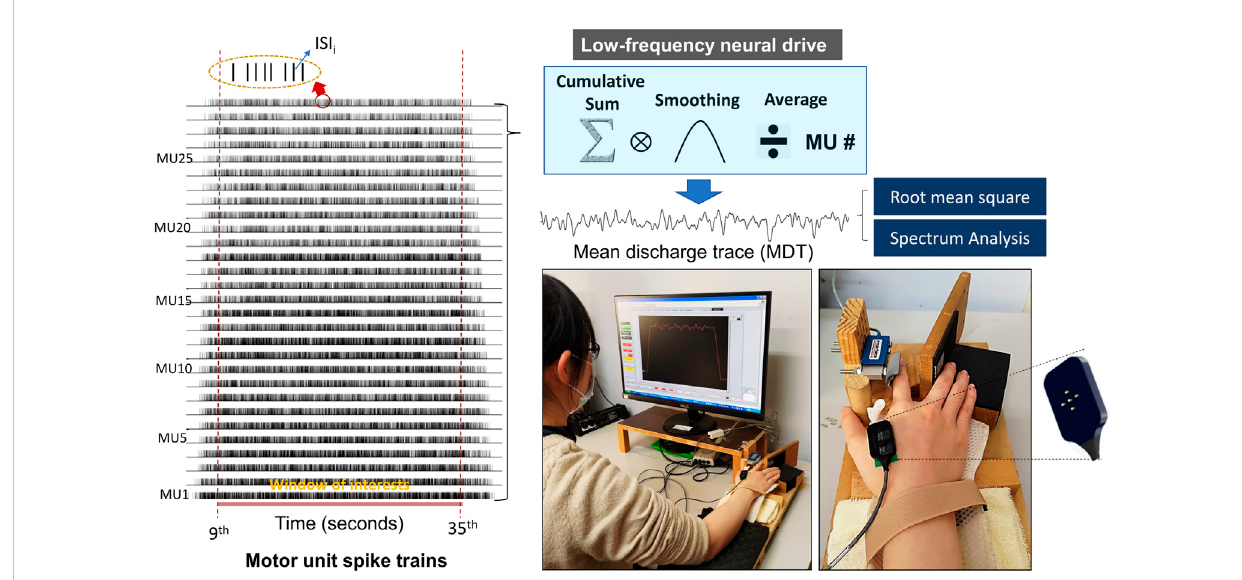
FIGURE 2 Decomposition results of surface electromyography (EMG) and acquisition of mean discharge trace (MDT) from the cumulative spike train. The smoothing process was performed by convolution of the cumulative spike trains of all identi fi able motor units with a Hanning window of 400 ms in duration. Root mean square and spectrum analysis were applied to the MDT in the pre-test and